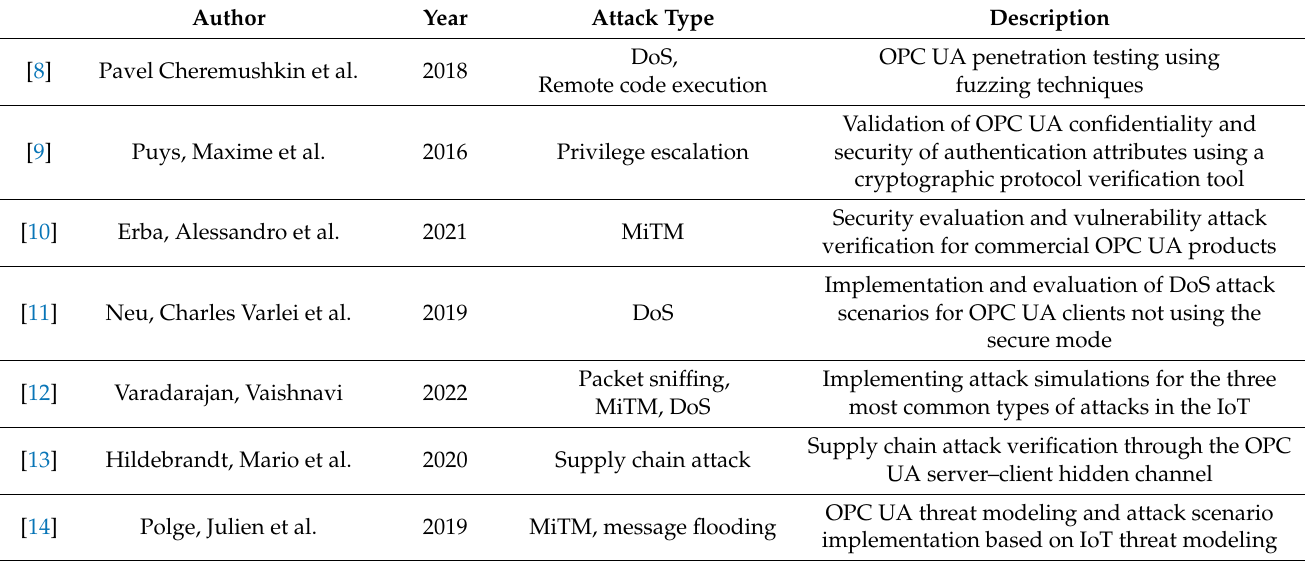
Table 5. Summary of papers related to OPC UA penetration